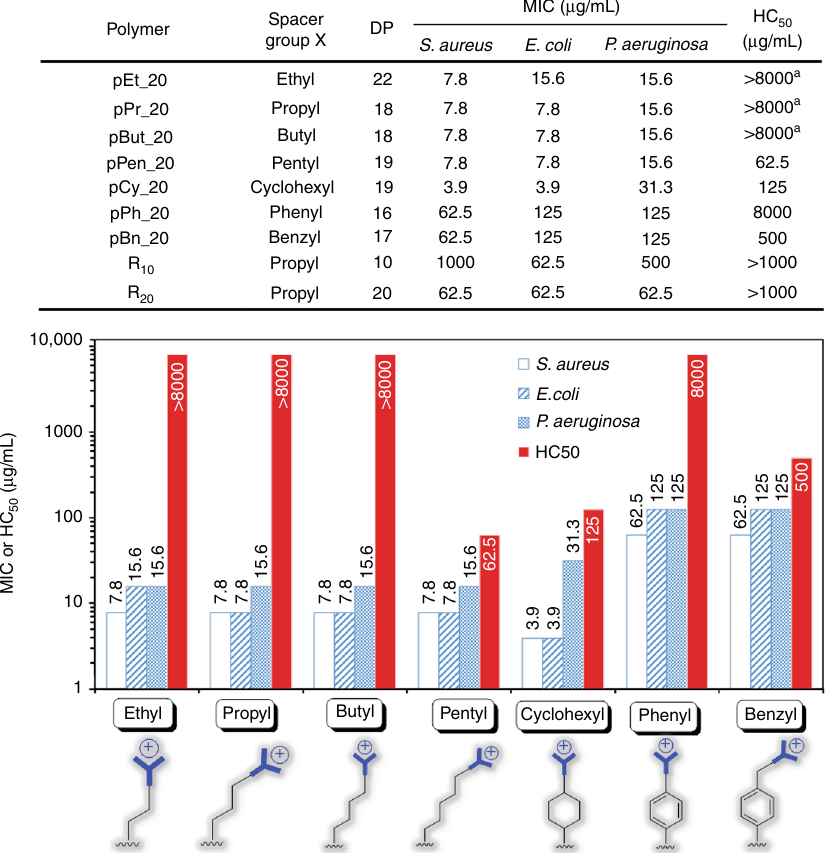
Fig. 2 Antimicrobial (MIC) and hemolytic (HC 50 ) activities. R 10 and R 20 represent arginine peptide with 10 and 20 amino acids, respectively. a At the highest concentration (8000 µ g/mL) tested, extent of hemolysis: <5%. The extent of hemolysis for pPh_20 at the threshold limit of 8000 µ g/mL: ∼